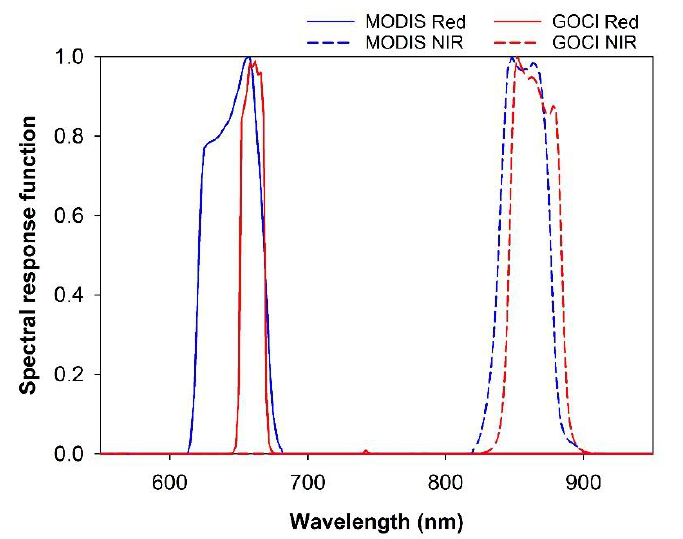
Figure 2. Spectral response function (SRF) of Moderate resolution Imaging Spectroradiometer (MODIS) (in blue) and GOCI (in red). The straight and dashed lines correspond to visible and near-infrared wavelengths, respectively.